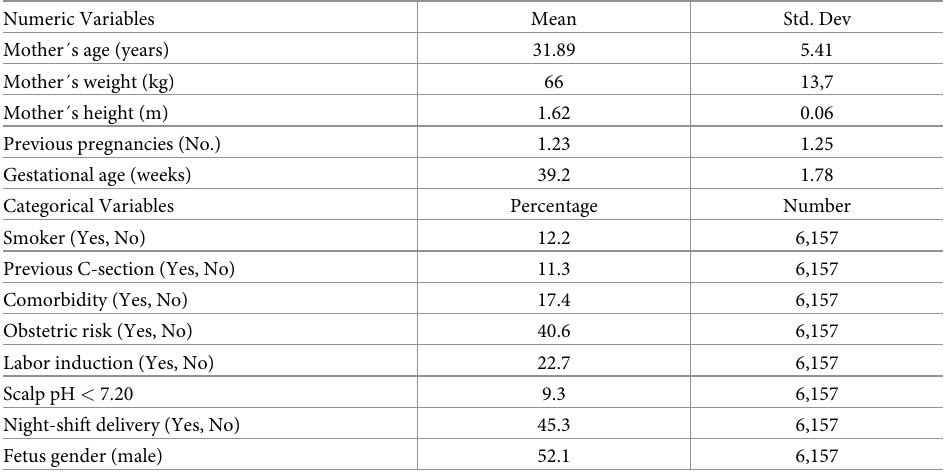
Table 3. Descriptive population